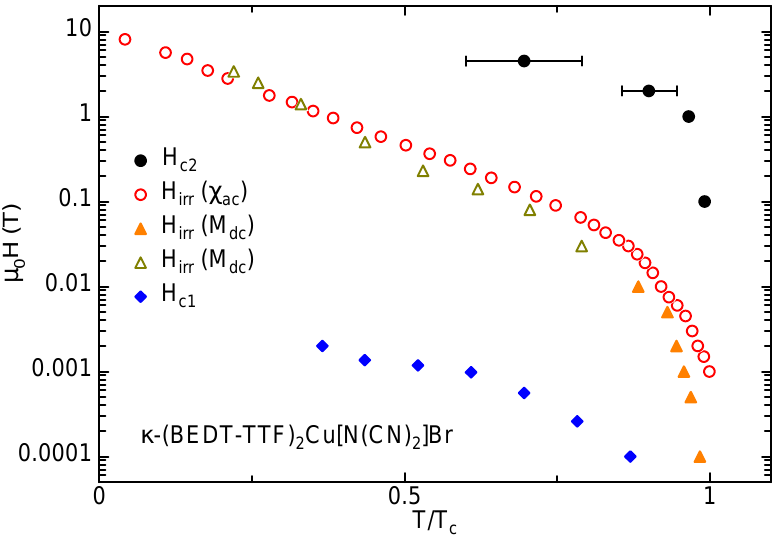
Figure 3. Temperature dependences of the lower ( H well as the irreversibility fields ( H perpendicular to the ET layers. The data for H are taken from